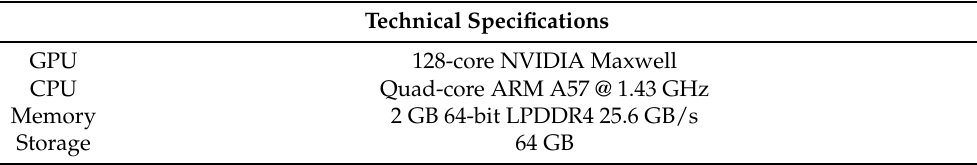
Table 1. Technical Specifications.